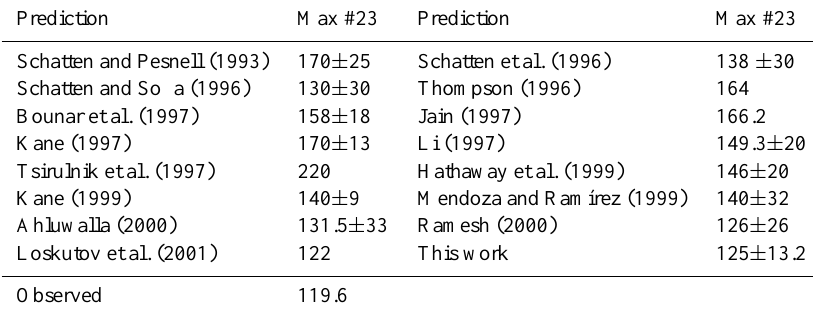
Table 1. Results of solar cycle 23 peak prediction by several authors using different techniques.